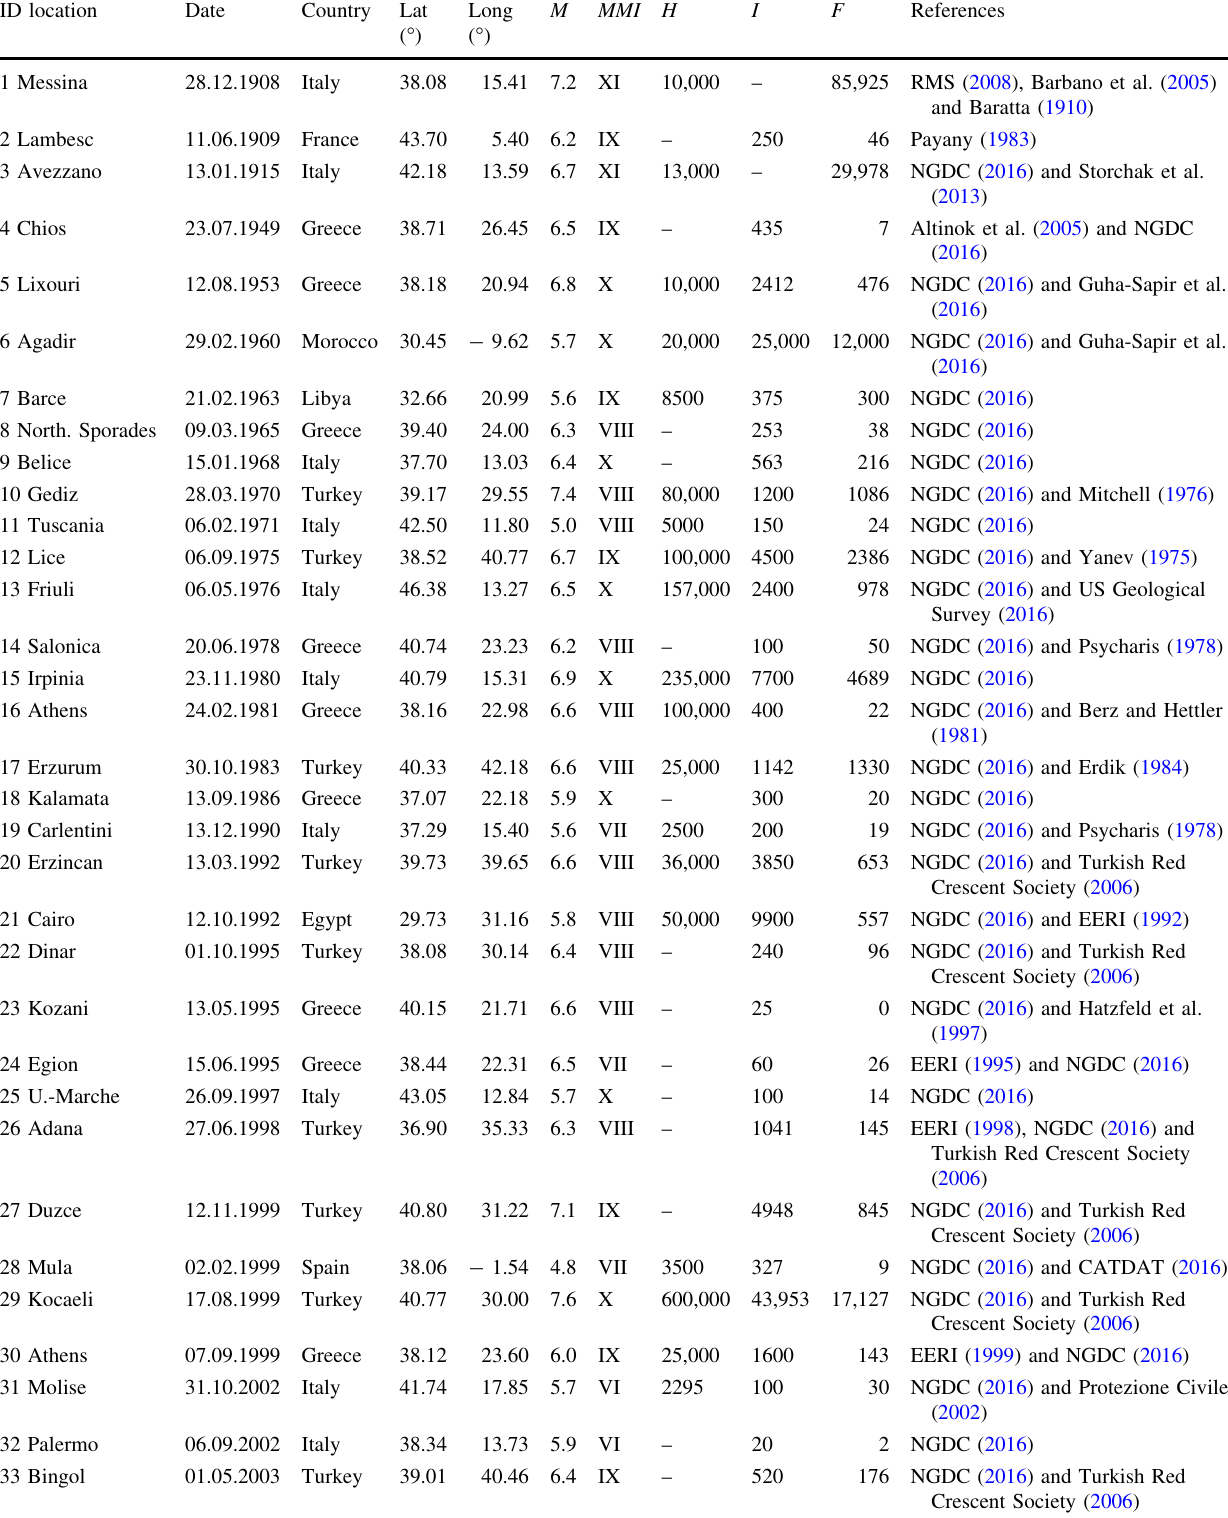
Table 1 Mediterranean earthquakes from 1900 to 2015 compiled in the database, with the Algerian earthquakes listed separately at the end ID